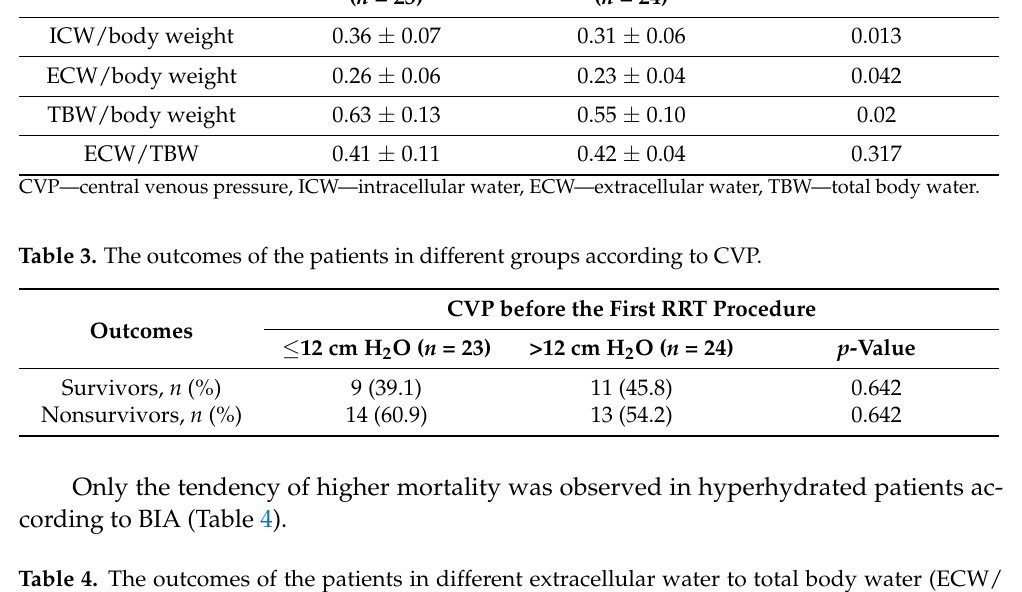
Table 2. The comparison of bioimpedance parameters before the first procedure of the renal re- placement therapy in separate CVP groups.